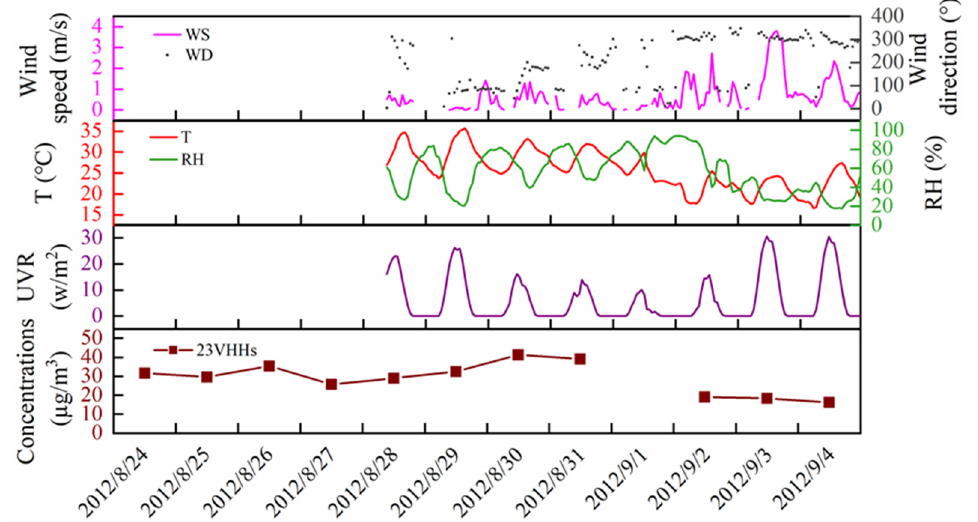
Figure 5. Daily variation of the mass concentrations of volatile halogenated hydrocarbons and meteorological factors in the study